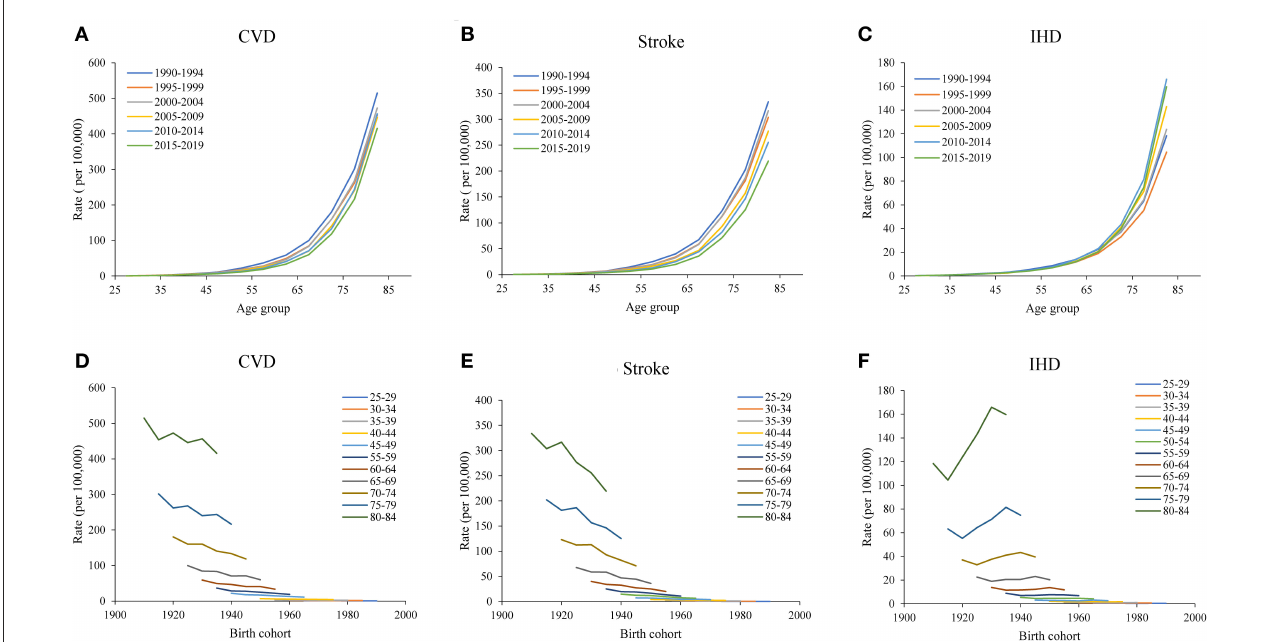
FIGURE2 Age-specific mortality of CVD attributable to non-optimal temperatures from 1990 to 2019 and cohort-specific mortality of CVD attributable to non-optimal temperatures from 1990 to 2019. (A – C) Survey years were arranged into consecutive 6-year periods from 1990 to 1994 (median, 1992), 1995 to 1999 (median, 1997), 2000 to 2004 (median, 2002), 2005 to 2009 (median, 2007), and 2010 to 2014 (median, 2012), and the CVD, stroke, and IHD mortality attributable to non-optimal temperatures increased with age group. (D – F) , the data of CVD, stroke, and IHD mortality attributable to non-optimal temperatures were arranged into 17 consecutive birth cohorts, including those born from 1910 to 1914 (median, 1912) to 1990 to 1994 (median, 1992), and successive 5-year age intervals from 25 to 29 years (median, 27 years) to 80 to 84 (median, 82 years) years of age.